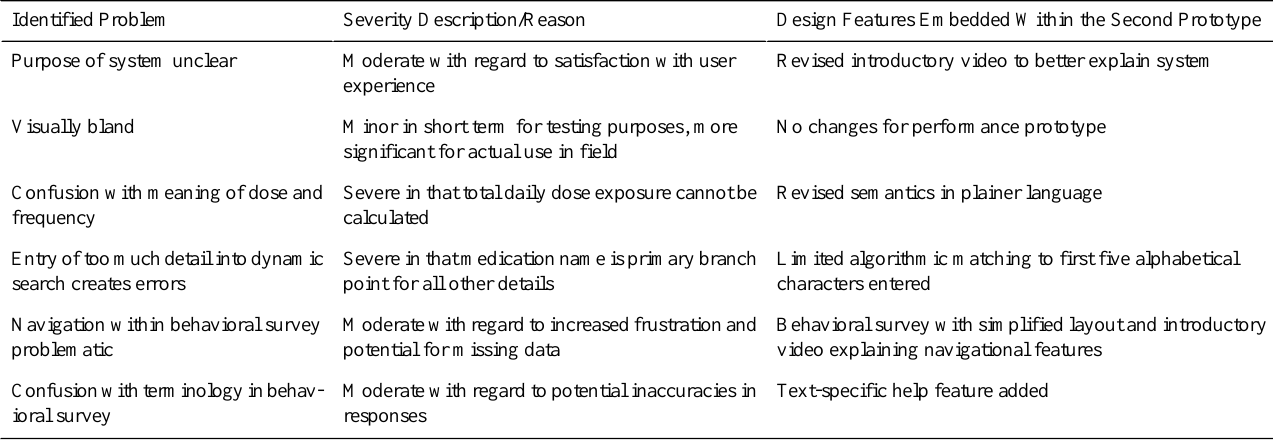
Table 3. Summary of problems identified in usability testing and solutions incorporated into second prototype of the ADHD personal health application fieldVisually bland